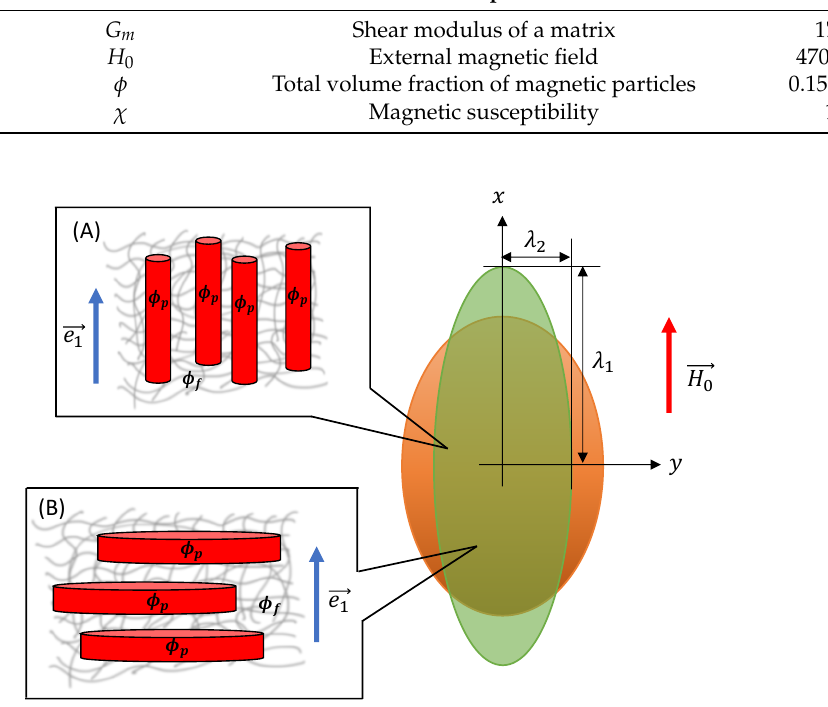
Figure 3. Uniaxial deformation of an ellipsoidal MAE sample with different microstructures. The orange-coloured MAE sample represents the reference configuration, while the green-coloured sample depicts the deformed configuration. φ p is the volume fraction of magnetizable particles inside a smeared structure, and φ f = φ represents the volume fraction of smeared structures inside an φ p elastomer matrix. ( A ) SC microstructure and ( B ) SD